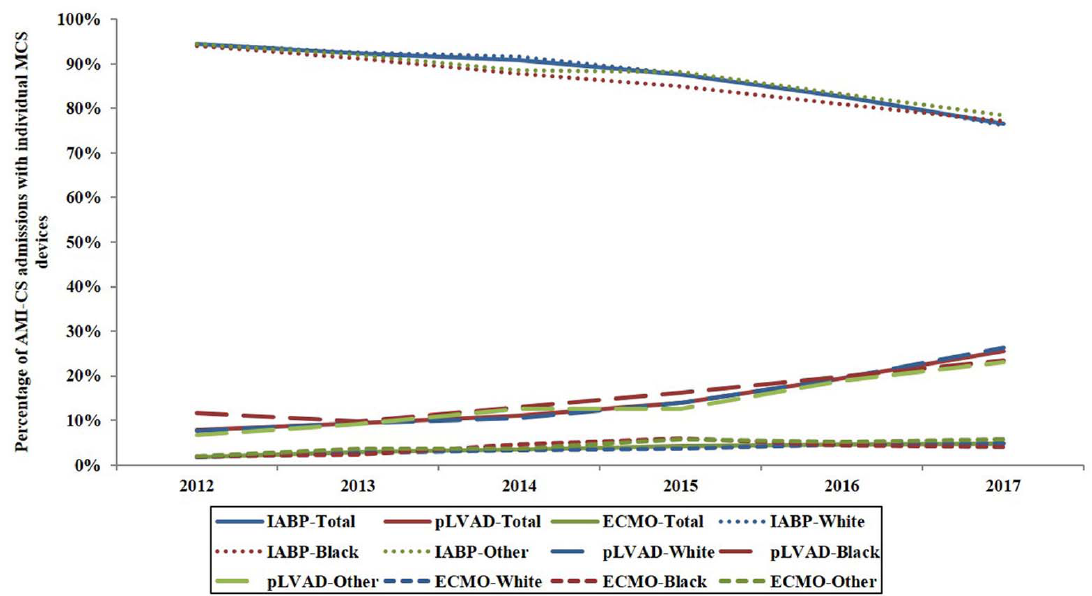
Figure 2. Trends in the use of MCS devices in race sub ‐ groups of AMI ‐ CS admissions. All p < 0.001 for temporal trend. Abbreviations: AMI: acute myocardial infarction; CS: cardiogenic shock; ECMO: extracorporeal membrane oxygenation;